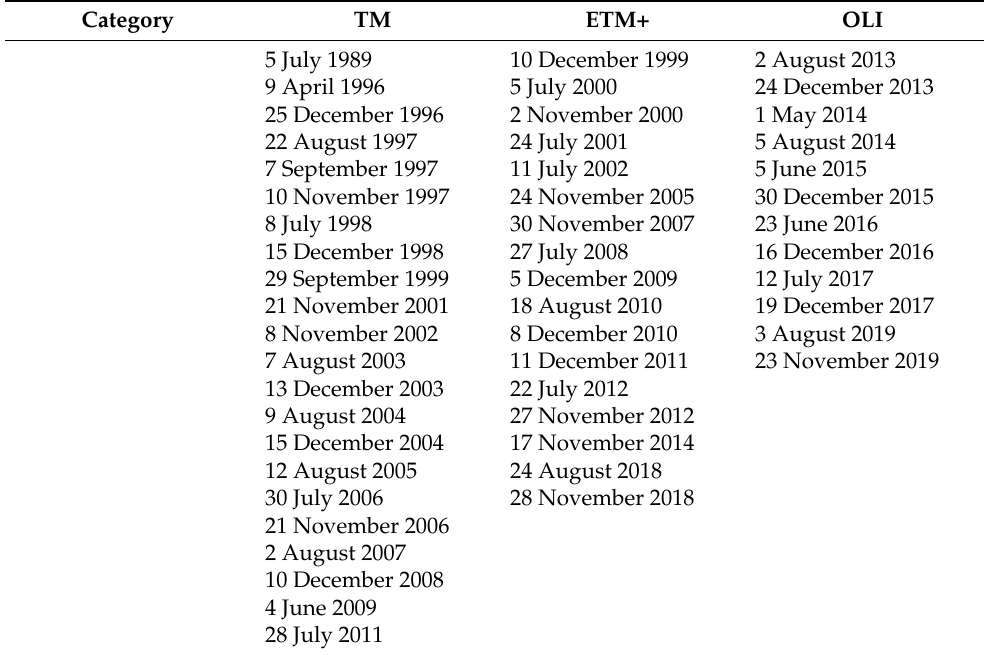
Table A2. Landsat images used in the map processing and the dates when the images were taken. Path/row: 121/39 (Landsat Path/Row World Reference